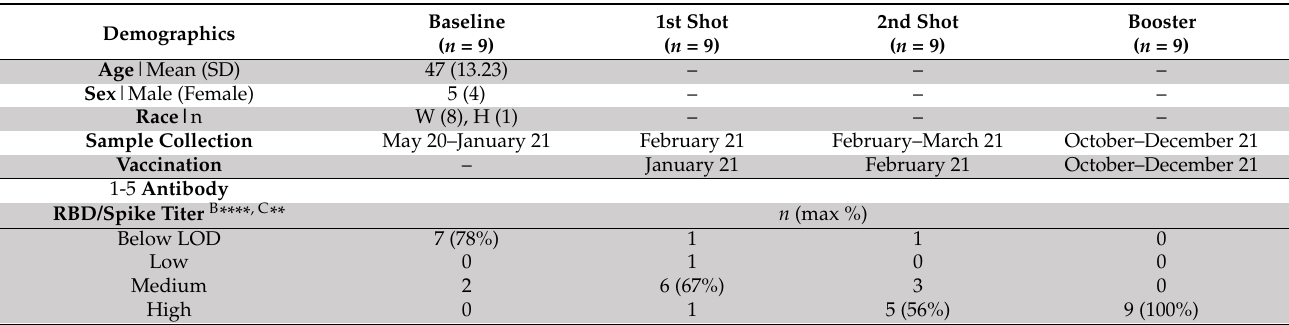
Table 1. Study subjects’ demographics and clinical characteristics ( n = 9). Demographics, such as age and sex, as well as Ab titers, serum neutralization, and sequence data, are shown across each of the four timepoints. Ab titers were categorized as below limit of detection ( ≤ 1:40),